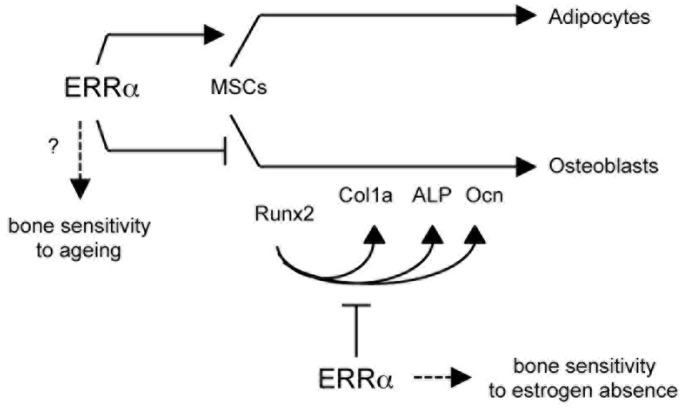

In vivo and ex vivo effects of ERRα on bone.ERRα impairs the later steps of osteoblastic differentiation. The results presented here show that these activities are involved in bone loss induced by estrogen deficiency and may involve the repression of Runx2- driven transcriptional activities. In contrast, these activities are not involved in bone sensitivity to ageing. Data published by other show that ERRα also promotes the early commitment of mesenchymal stem cells (MSCs) toward the adipocytic pathway while restricting the osteoblastic one. We hypothesize that these early activities are responsible, at least in part, for bone loss induced by ageing. See text for details and references.